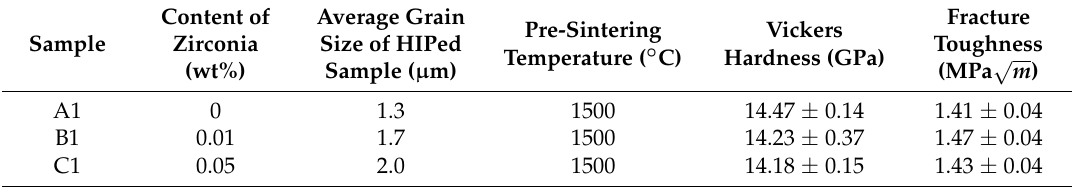
Figure 4. Microstructure of samples A, B, and C pre-sintered at different temperatures (1, 1500 °C; 2, 1515 °C; 3, 1525 °C; 4, 1550 °C) and HIPed at 1550 °C. Table 1. Vickers hardness and fracture toughness of samples with optimal in-line transmittance.